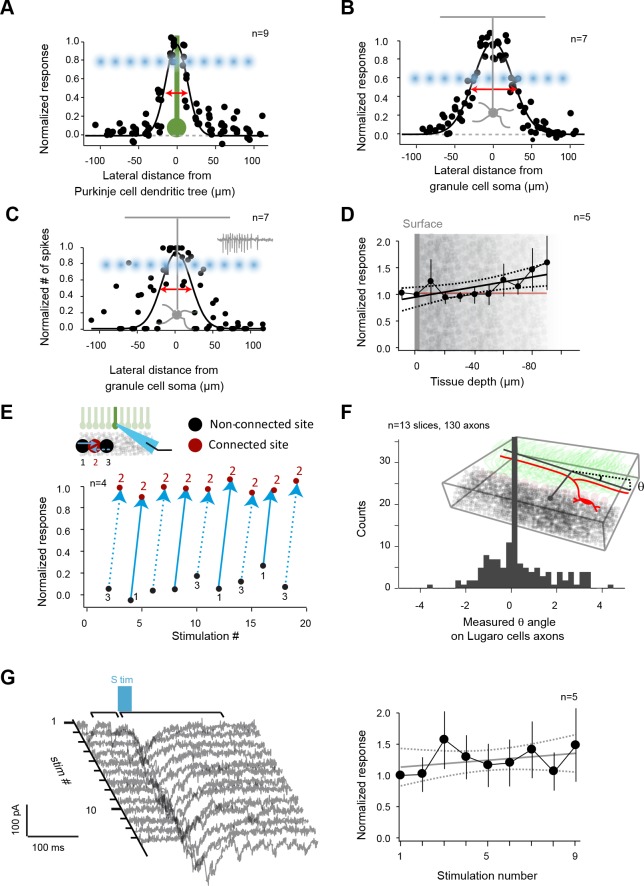
Controls for photostimulation.(A) Normalized direct current extent in Purkinje cells (PCs) when the spot of illumination (blue dots) is moved through PC dendrites (green); illumination step: 20 μm. (B) Normalized direct current extent in granule cells (GCs) when the spot of illumination is moved through GC dendrites (step: 20 μm). (C) Normalized number of spikes elicited in GCs when the spot of illumination is moved through GC dendrites (step: 20 μm). (D) Normalized direct current response in GCs as a function of focal plane depth in slices. (E) Evaluation of independence between neighboring sites. Site 2 evoked a current in a recorded PC, but not sites 1 or 3, although they are direct neighbors. All three sites are alternatively stimulated to test for a possible spread of glutamate between sites or desensitization of glutamate receptors on site 2. (F) Distal silent sites might be due to a tilt in the slice. Slice angle was verified using Lugaro cell axons that parallel GC axons in Glyt2-GFP mice in order to rule out this hypothesis. (G) Left panel: a responding site was repetitively photostimulated to test the stability of recorded responses throughout mappings. Right panel: measured synaptic charge versus time.